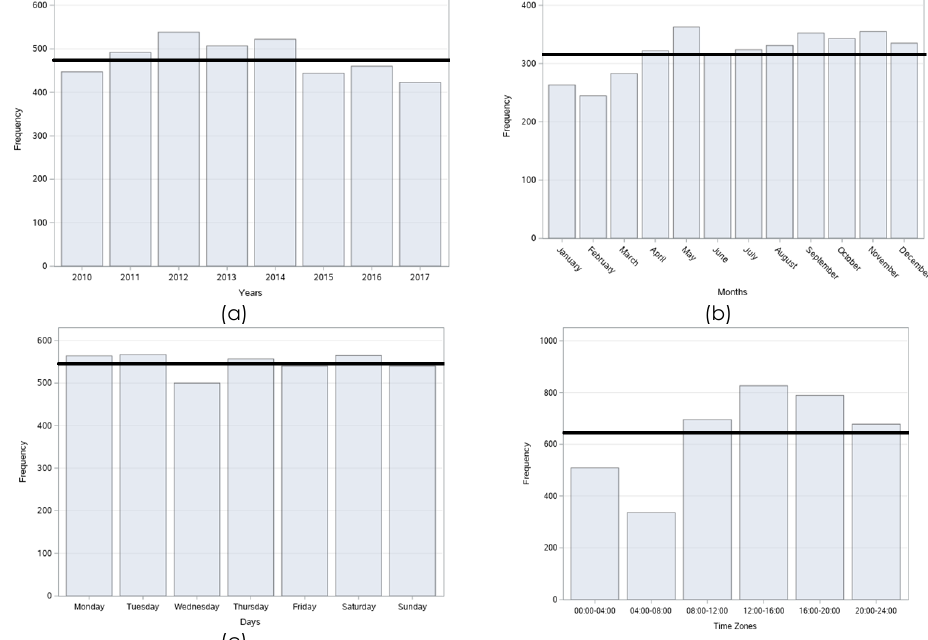
Figure 3. Bar graphs of the number of traffic accidents in Şişli district: (a) By years; (b) By months; (c) By days; (d) By time